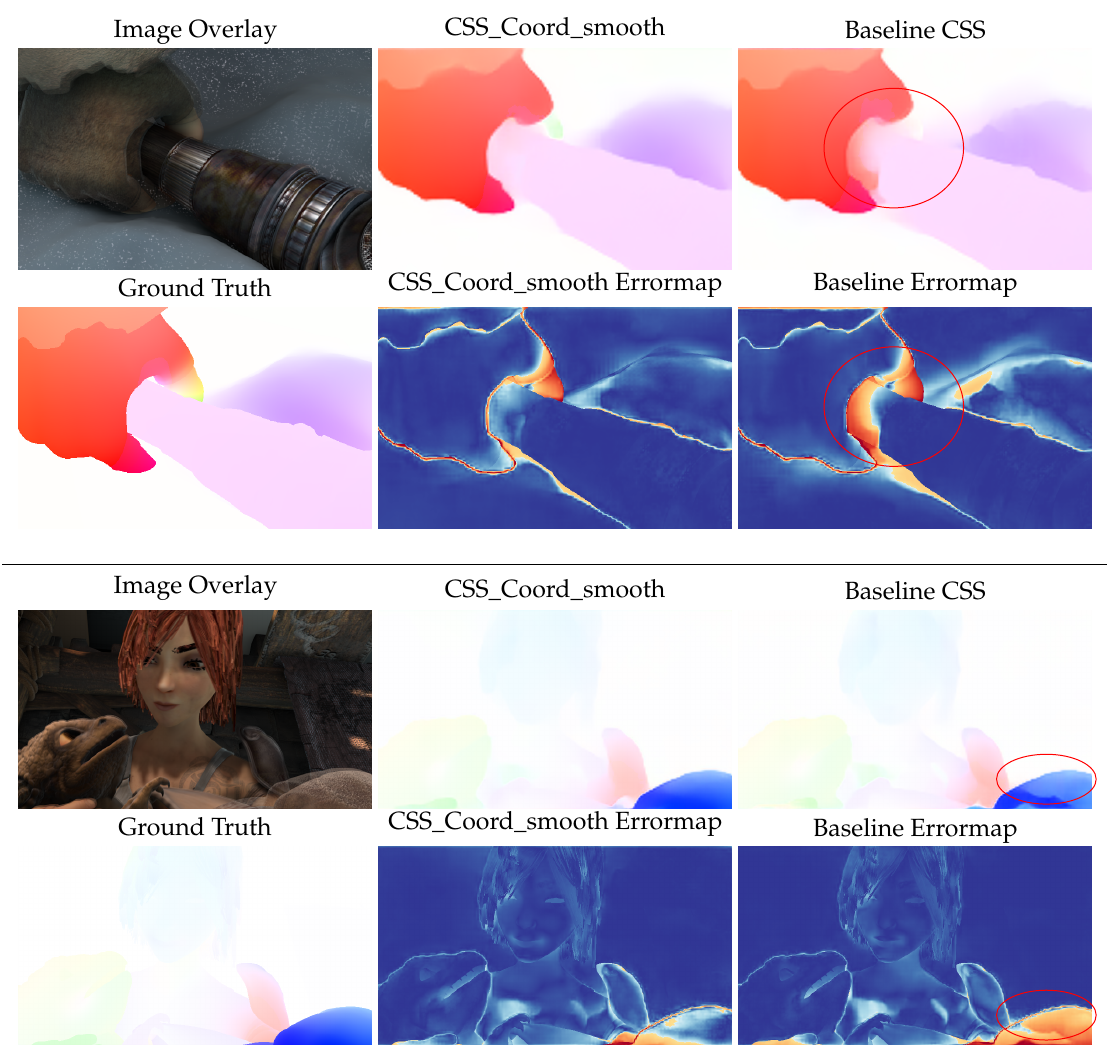
Figure 16. Qualitative results on MPI Sintel dataset. Although the baseline network overfits and presents lower error magnitudes on this synthetic dataset, our method maintains its qualitative edge, producing flow vectors that adhere to object boundaries.